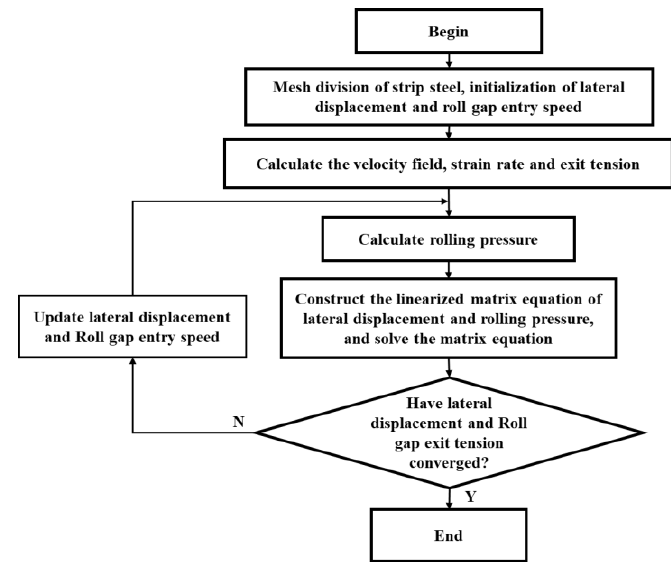
Figure 4. The strip model calculation process .